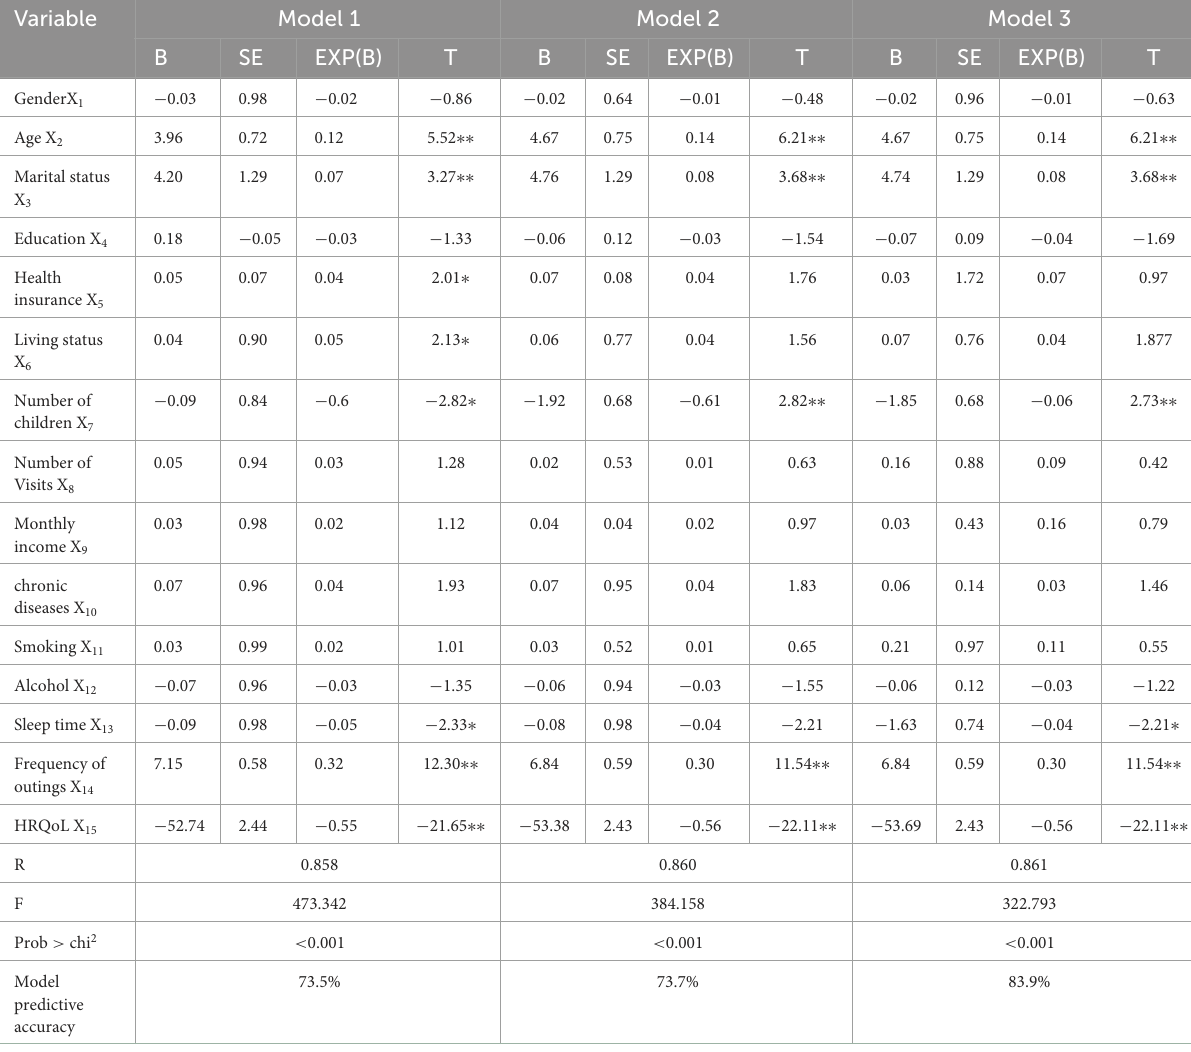
TABLE 2 Multiple linear regression analysis of perceived participation and autonomy of community homebound older adults.